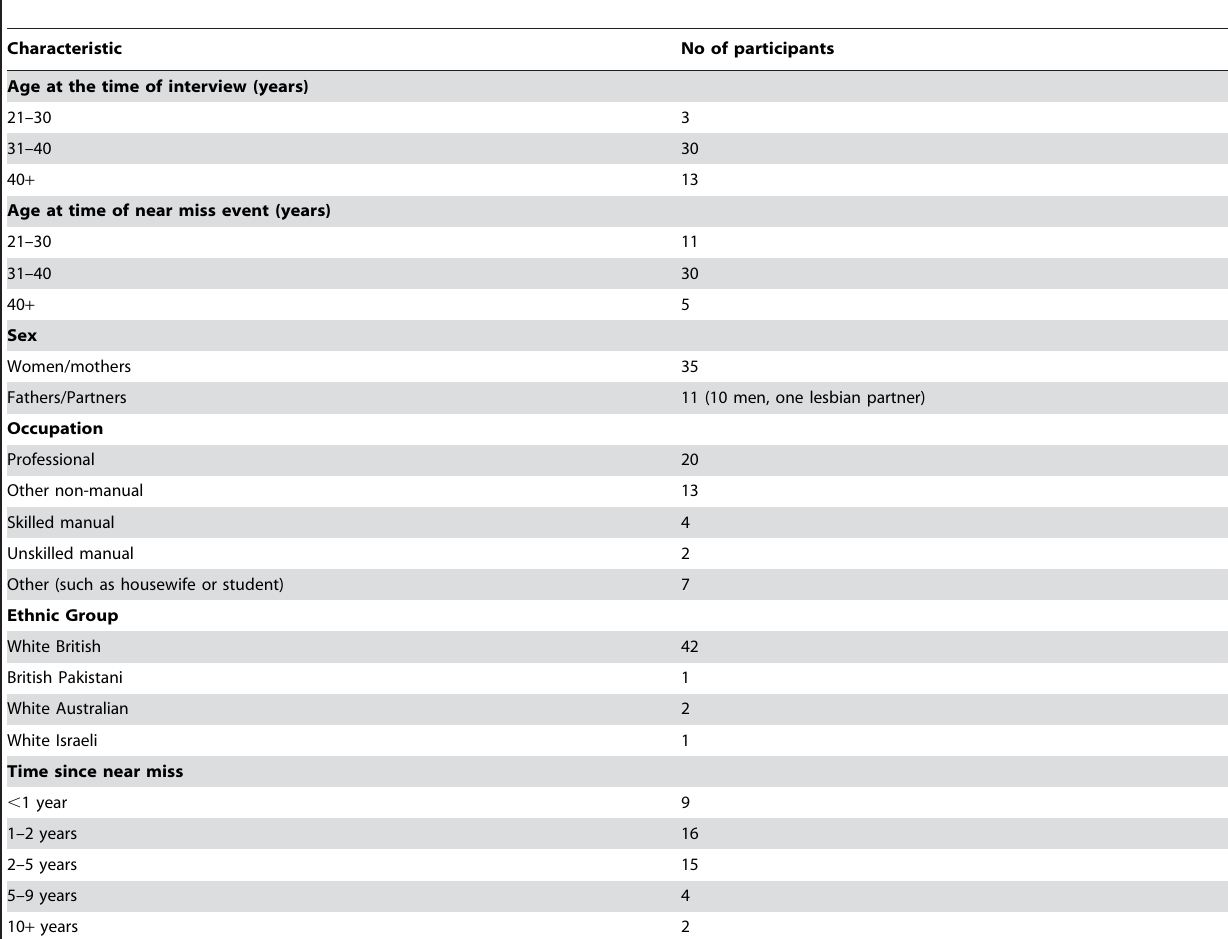
Table 2. Socio-demographic characteristics of 46